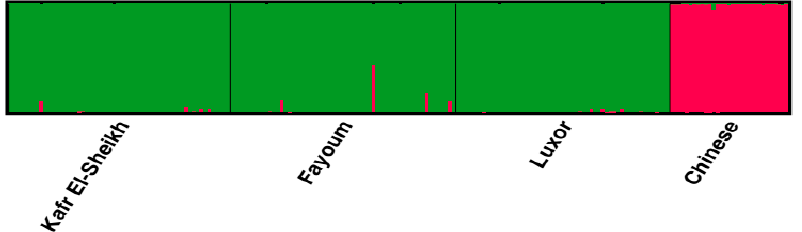
Figure 6. Structure clustering of the three Egyptian and Chinese populations obtained for K = 2.